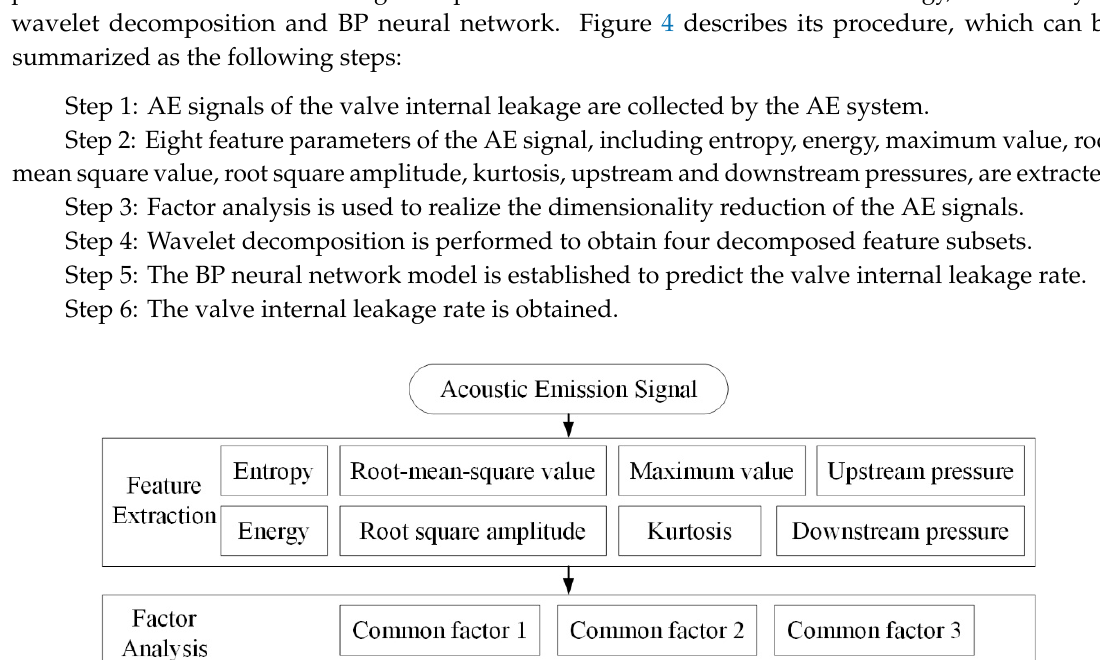
Figure 3. Experimental platform for detection valve internal leakage in the gas pipeline.